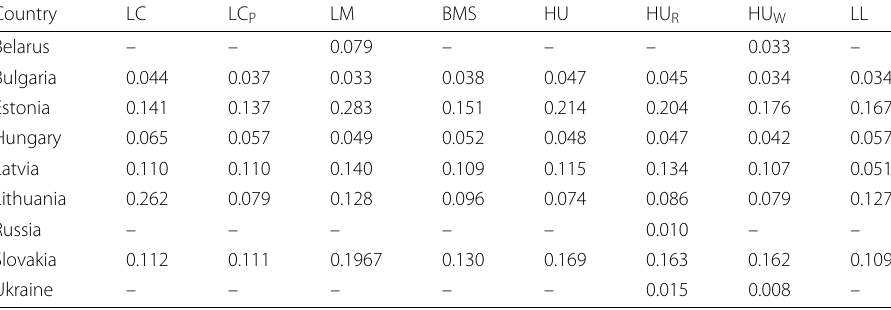
Table 4 One-step-ahead forecast bias of the fitted models in terms of MSE Country LC LC P LM